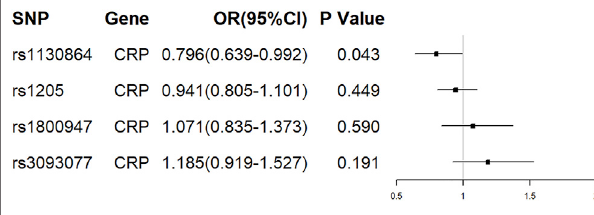
FIGURE 2 | The effect of single conservative CRP genetic variants on ALS. OR, odds ratio; CI, con fi dence interval.